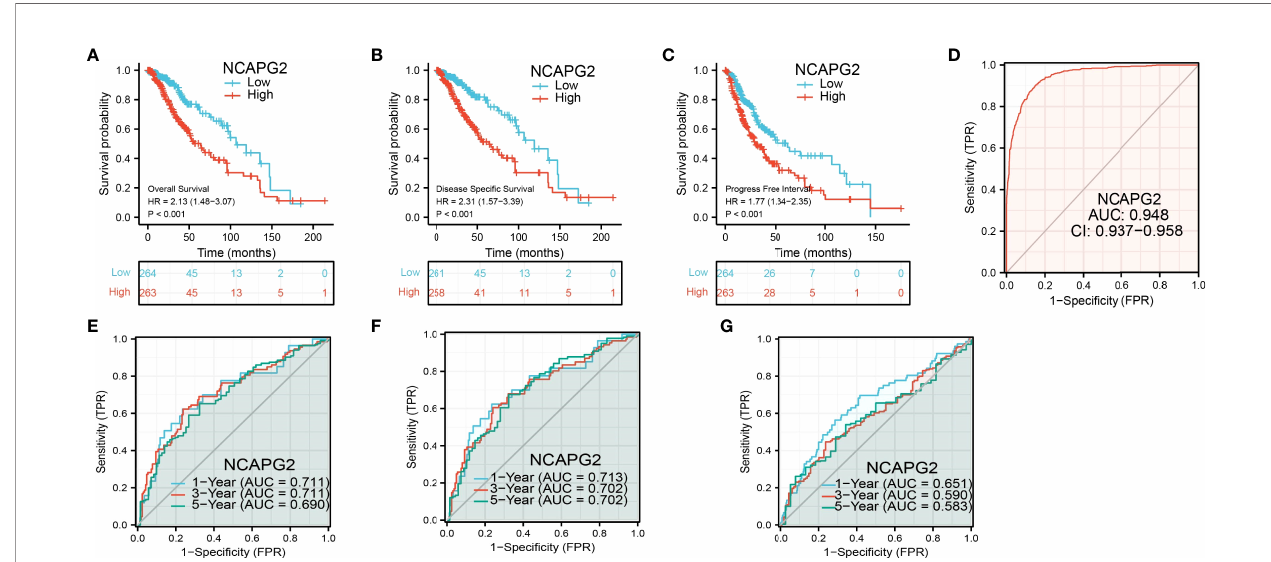
FIGURE 3 | Prognostic and diagnostic value of NCAPG2 (A-C) Kaplan – Meier survival curves showed that LGG patients with high NCAPG2 expression exhibited poor overall survival, disease-speci fi c survival and progression-free survival of NCAPG2 in LGG determined by TCGA-LUAD dataset. (D-G) Time-dependent ROC curves were used to determine the diagnostic value of NCAPG2 in LGG.